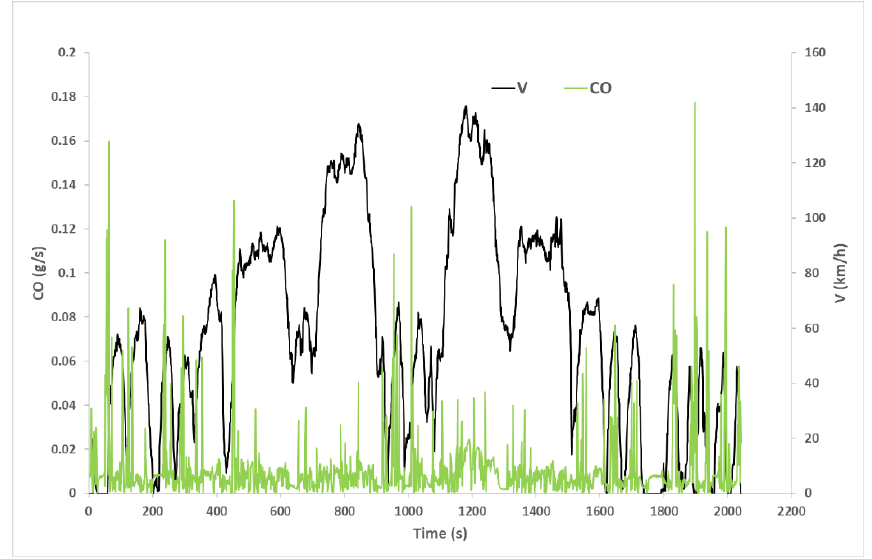
Figure 14. CO emission versus vehicle speed in on-road test, CNG propulsion.